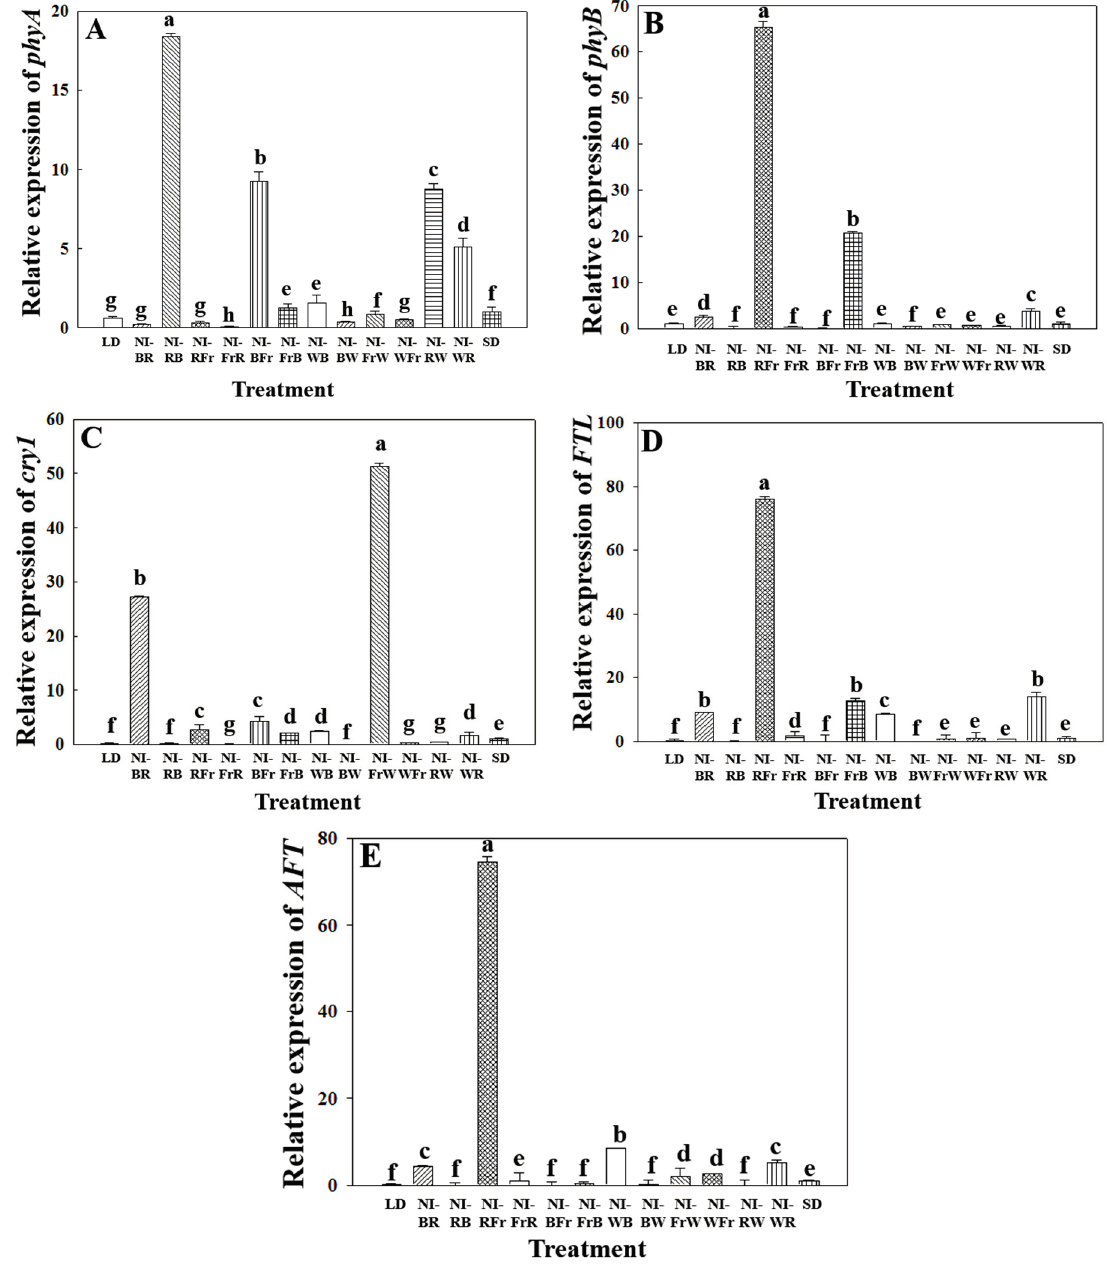
Figure 3. Relative gene expression of ( A ) phyA ( B ) phyB ; ( C ) cry1 ; ( D ) FTL ; and ( E ) AFT of Dendranthema grandiflorum “Gaya Yellow”. Vertical bars indicate ± S.E of the means for n = 3. Means accompanied by different letters are significantly different ( p < 0.05) according to the Tukey’s studentized range